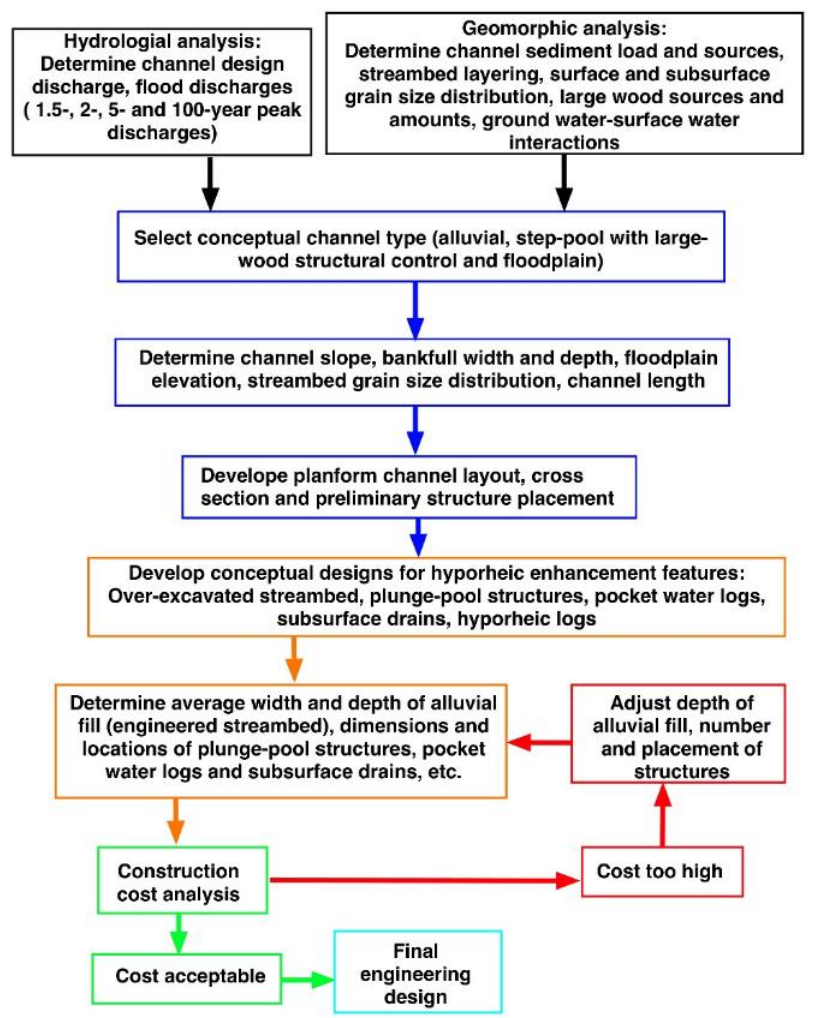
Figure 4. Project design process flowchart.